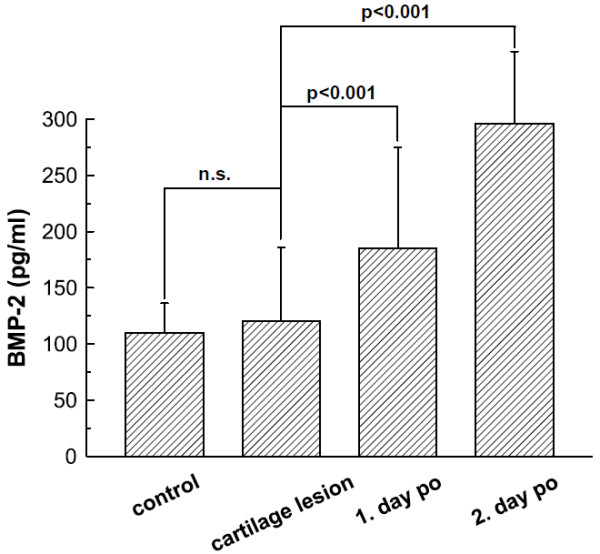
BMP-2 Course. BMP-2 content in lavage fluids of knee joints without cartilage lesions (control, n = 5), with cartilage damage (n = 42), following cartilage surgery at day 1 (n = 28) post operation (po), and following cartilage surgery at day 2 (n = 6) post operation. Groups were compared as indicated by the connecting lines, significance levels are specified.